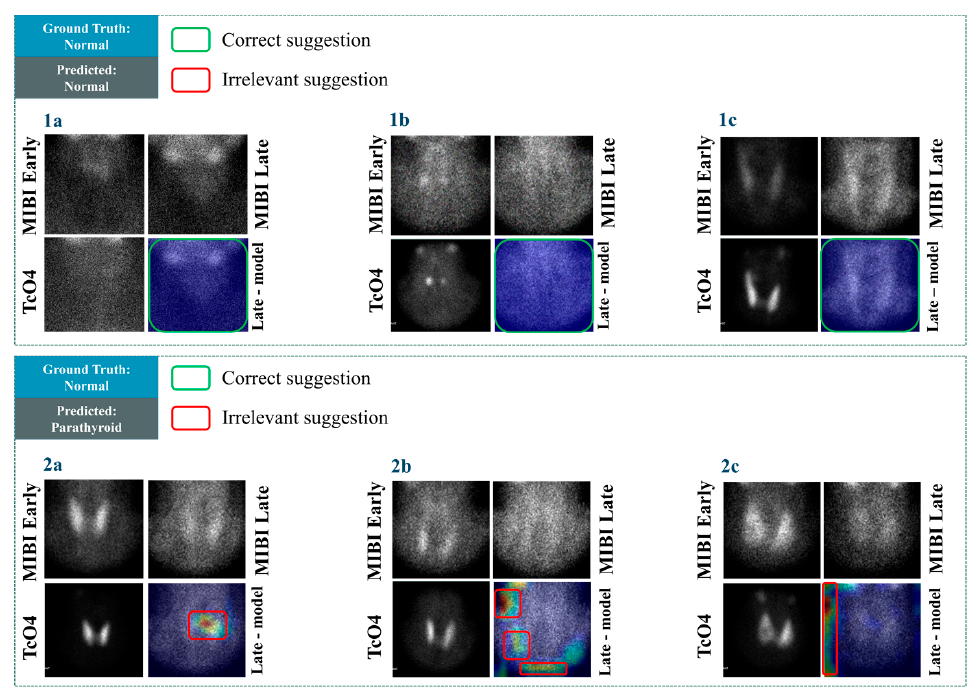
Figure 7. Grad-CAM results in some cases with negative scintigraphic results.